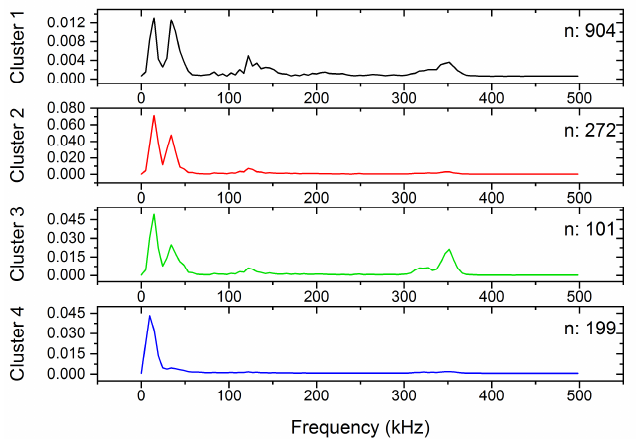
Figure 2. The average PSD functions, as the centroids of the clusters, including the number of avalanches at − 30 °C.